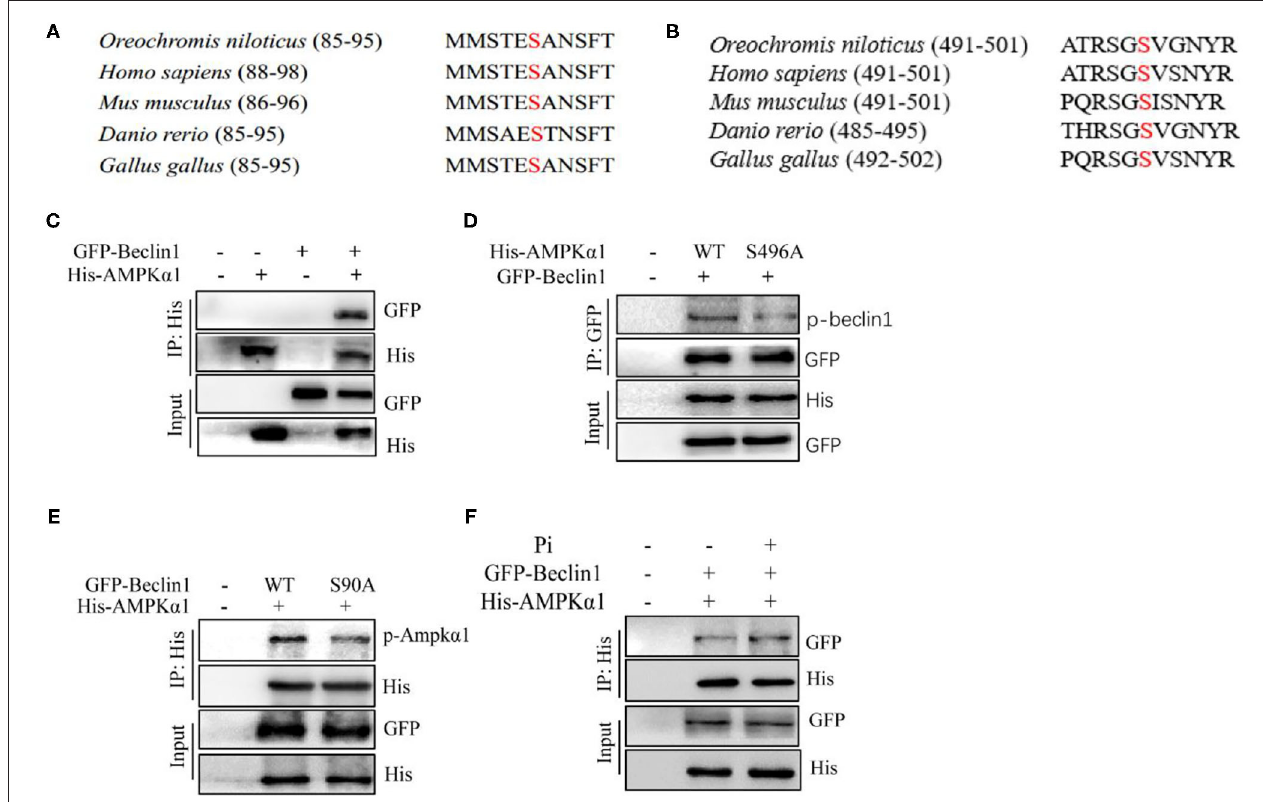
FIGURE 9 | Phosphorylation of Beclin1 by AMPK is necessary for Pi-induced autophagy to degrade LD. (A) Alignment of the partial Beclin1 protein sequences among several species. Red S indicates putative serine sites where Beclin1 could be phosphorylated. (B) Alignment of partial AMPK α 1 protein sequences among several species. Red S indicates putative serine sites where AMPK α 1 could be phosphorylated. (C) The interaction between AMPK α 1 and Beclin1. His-tag AMPK α 1 and GFP-tag Beclin1 were transfected into the HEK293T cells. (D) Mutations of S496A reduced the Beclin1 phosphorylation level. Phosphorylation of the ectopically expressed WT and S496A was analyzed. (E) Mutations of S90A decreased the AMPK α 1 phosphorylation level. Phosphorylation of the ectopically expressed WT and S90A was analyzed. (F) The interaction between AMPK α 1 and Beclin1 after Beclin1 and AMPK α 1-overexpression and Pi treatment.